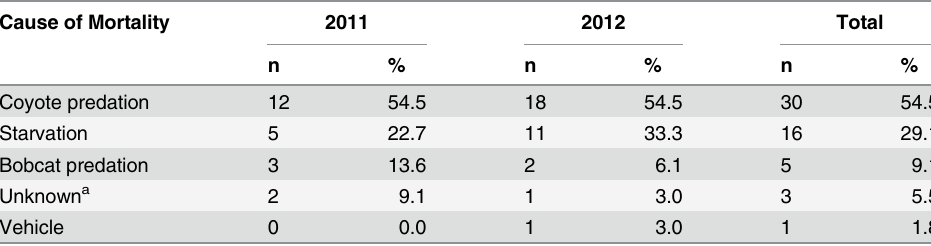
Table 5. Causes of mortality among radiocollared neonatal white-tailed deer at Fort Bragg Military Installation, North Carolina, 2011 – 2012.